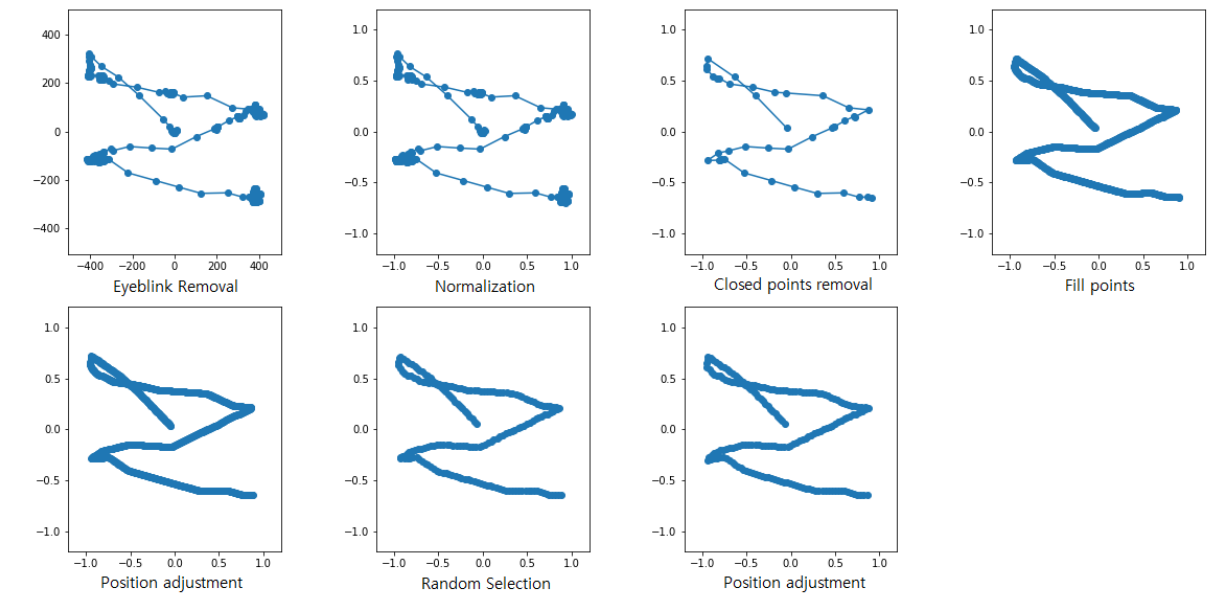
Figure 4. Changes of a signal throughout the resampling procedure.